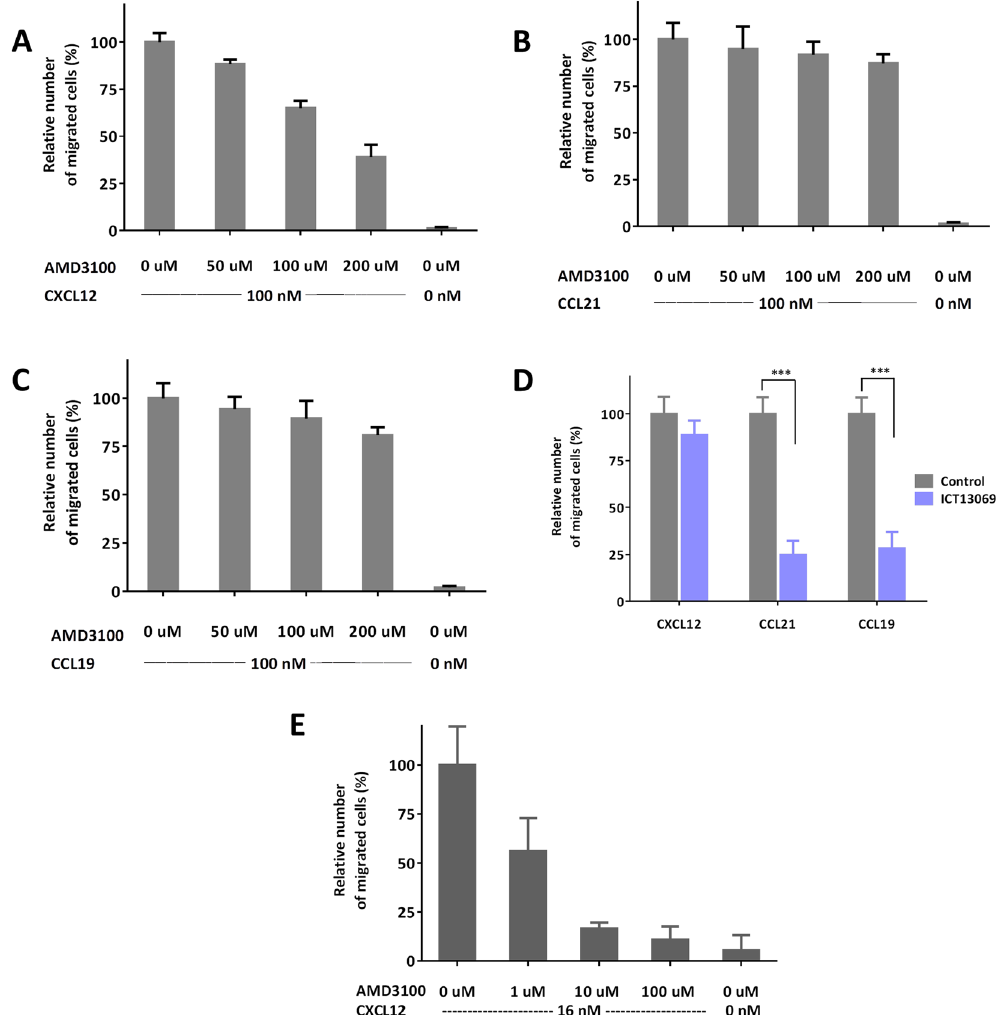
Figure 5. Cells migration under the agarose spot can be selectively modulated by antagonists. ( A ) Migration of PC-3 cells under agarose spot containing 100 nM CXCL12 (ligand for CXCR4), is modulated in a dose- dependent manner by CXCR4 selective antagonist, AMD3100. ( B and C ) However, migration of PC-3 cells under agarose spot is not abrogated by CXCR4 selective antagonist, AMD3100 for the spots containing 100 nM CCL21 and 100 nM CCL19 (ligands for CCR7). ( D ) Migration of PC-3 cells under agarose spot containing 100 nM chemokines in the absence (grey bars) or presence (purple bars) of CCR7 antagonist ICT13069 (10 µ M) shows that migration against CXCL12 is not modulated but that migration is reduced against CCL19 and CCL21. ( E ) Comparison of the inhibition of CXCL12 induced migration of PC-3 cells by AMD3100 in a Boyden